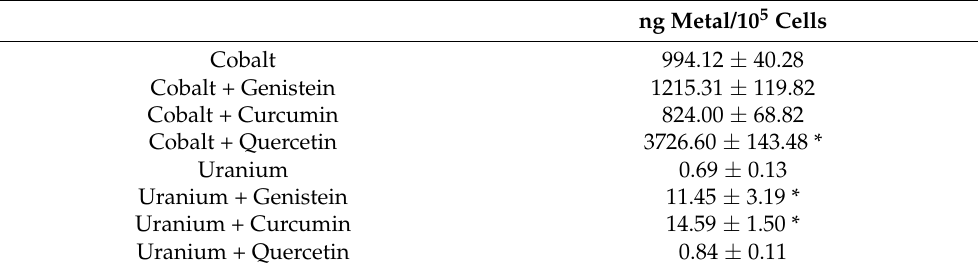
Table 2. Metal uptake by J774 cells in the absence and presence of nutraceuticals.